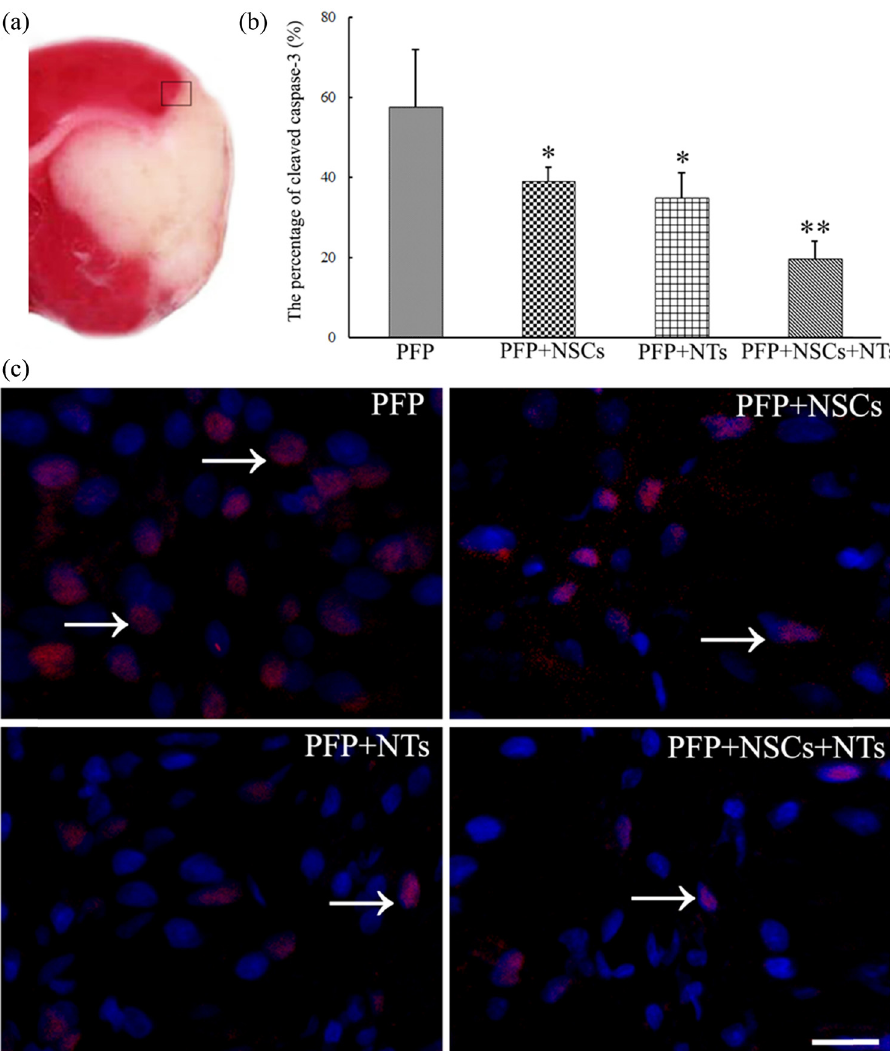
Figure 3: Transplantation of NSCs - polymer sca ff old reduced cells ’ death 7 days after transplantation. ( a ) Brain tissues in ischemic penumbra indicated by the box were collected. ( b and c ) Fluorescent staining with caspase - 3 antibody revealed the number of apoptosis. The images were captured by a Zeiss LSM 710 confocal microscope with a 20 × objective ( Red, caspase - 3; Blue, DAPI ) . Scale bar = 20 µm. The results are shown as the mean value ± SD ( * p < 0.05, ** p < 0.01 vs PFP group, n = 3 )